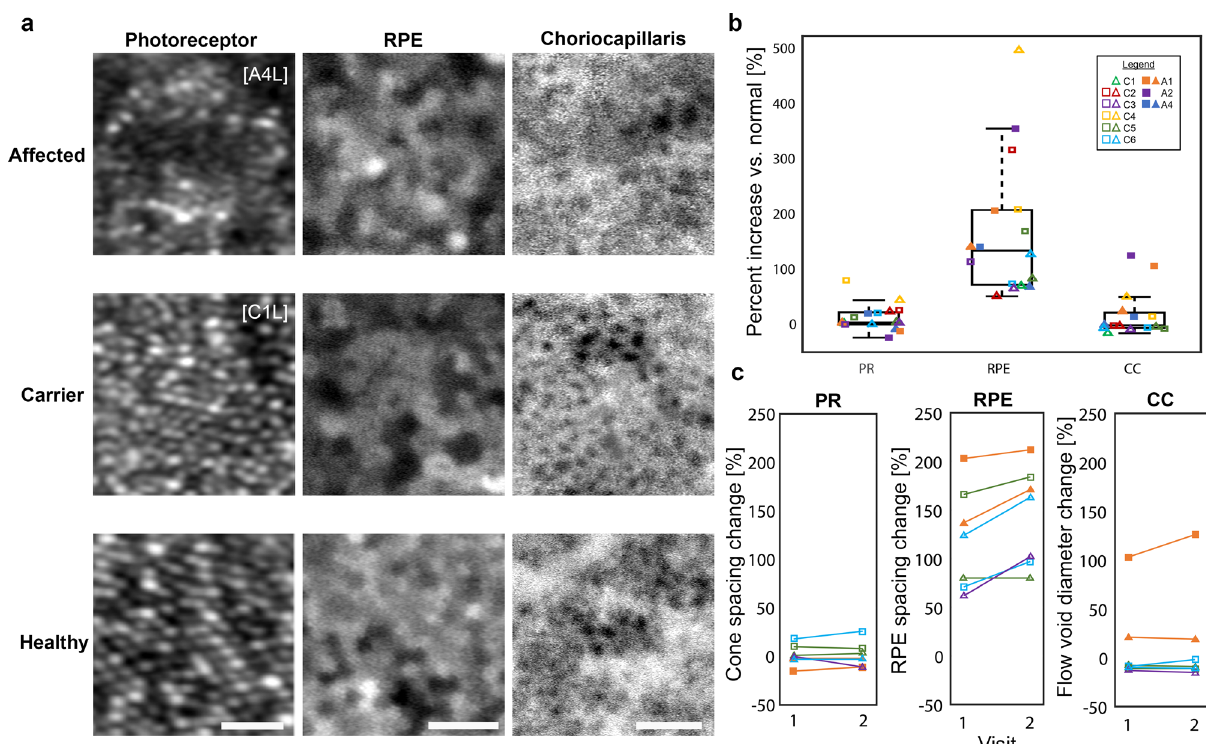
Fig. 3 Visualization of the photoreceptor, RPE, choriocapillaris complex in choroideremia. a AO images acquired at the fovea (eccentricity = 0.0 mm) showing foveal cone photoreceptors (PR), RPE cells, and the choriocapillaris (CC) microvasculature. Images from an affected male, a female carrier, and a healthy eye are shown. Note that subject A4L has a relatively well-preserved island of RPE cells at the fovea in which RPE cells are less enlarged compared to other affected males; outside of the fovea, RPE cells still form a contiguous monolayer but are dramatically enlarged (see Fig. 5a). Scale bars: PR, 10 µ m; RPE, 50 µ m; CC, 100 µ m . b Box plots of photoreceptor spacing, RPE spacing, and choriocapillaris fl ow void diameters show that the RPE is the most severely affected layer of these three layers (center line: median; box limits: upper/lower quartiles; whiskers: 1.5× interquartile range; points beyond the whiskers: outliers). Data corresponding to the subjects shown in ( a ) can be determined using the legend. Measurements of photoreceptors, RPE, and choriocapillaris performed in choroideremia were compared to normative histologic data 43 , normative in vivo RPE data 40 , and normative in vivo choriocapillaris data 36 , respectively. For subjects who had two visits, only data from the fi rst visit was used for this analysis. c Longitudinal imaging acquired next (time between visits varied between 2 and 12 months; Supplementary Table 1). The largest changes were observed in the RPE layer,